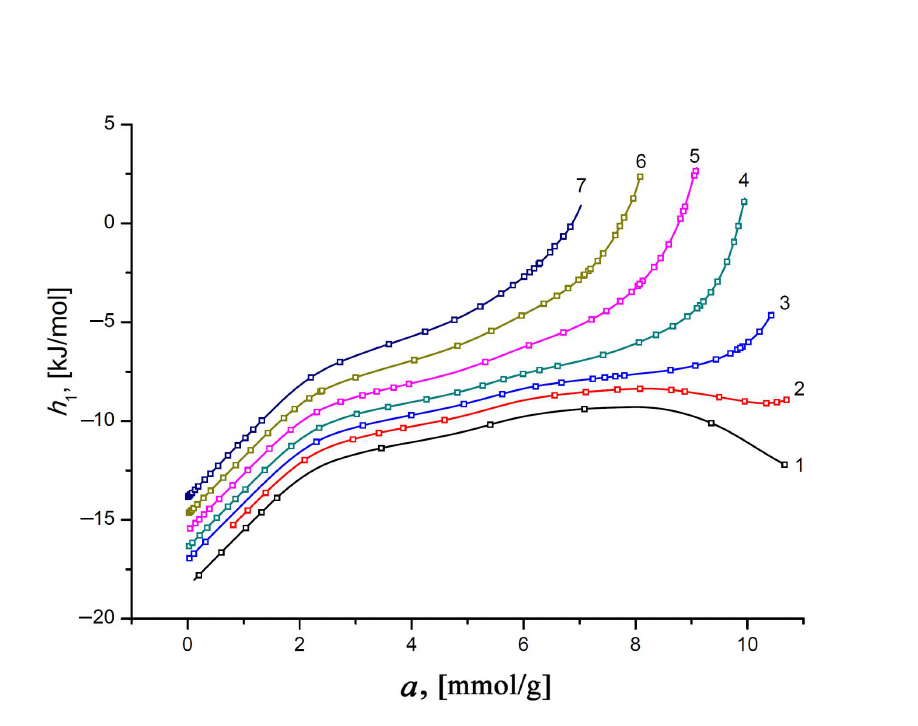
Figure 12. The differential molar enthalpy of the Xe/SiC-AC adsorption system versus the value of absolute Xe adsorption, a, at temperatures, K: 178 (1), 216 (2), 243 (3), 273 (4), 313 (5), 353 (6), and 393 (7). Symbols indicate the data calculated from the Xe adsorption data using Equations (8) and (13); solid lines are the smoothing spline